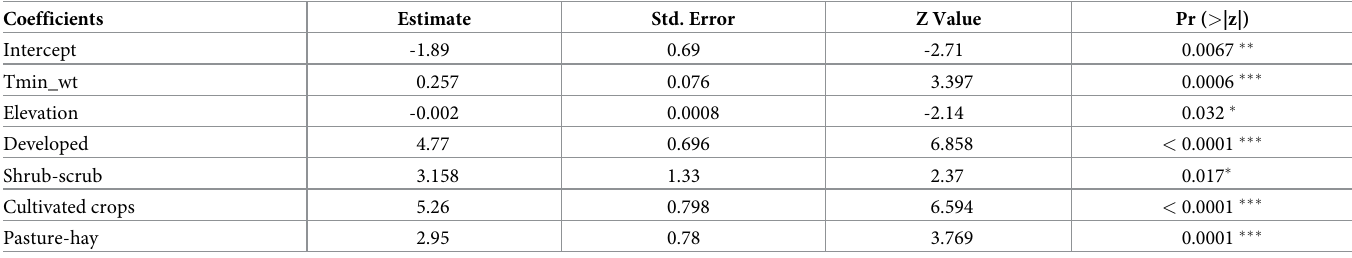
Table 3. GLM model results for R . pomonella . Significant variables include winter mean minimum temperature (Tmin_wt), land-cover classes (developed, shrub-scrub, cultivated crops, pasture-hay), and elevation. Though extreme minimum temperature over 30 years (EMT), winter degree days below 5˚C (DD5_wt), and frost-free period (FFP) were important, we did not include these variables in the model due to cross-correlations.